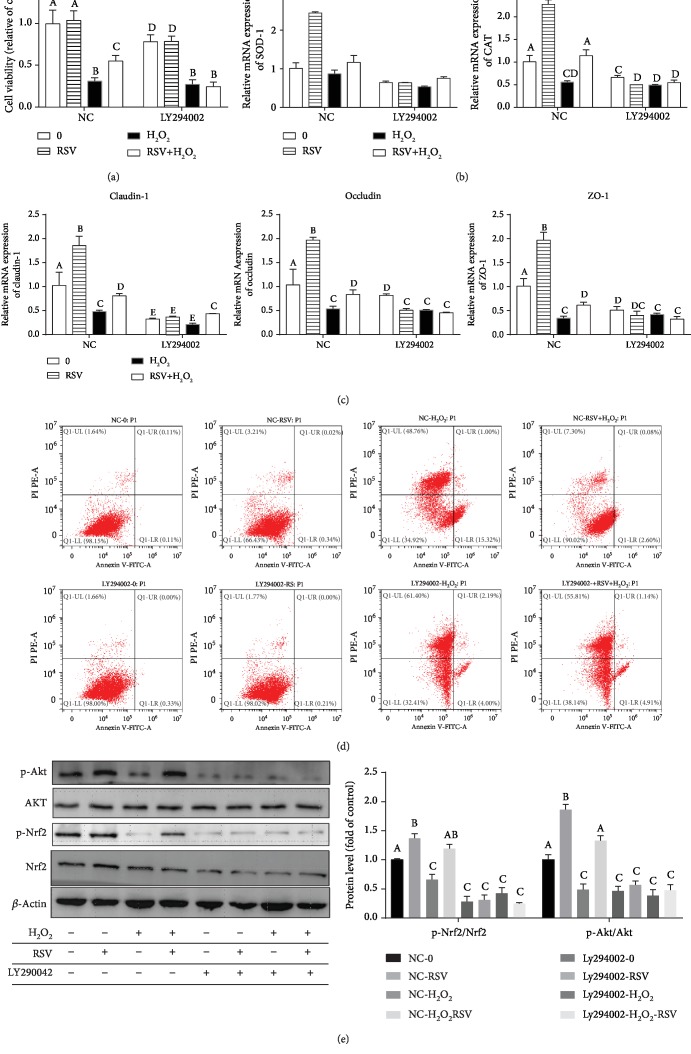
Effects of RSV and the selective inhibitor LY294002 on H2O2-induced cytotoxicity in IPEC-J2 cells. IPEC-J2 cells were pretreated with 25 μM LY294002 for 2 h and then treated with 50 μM RSV for 4 h before incubation with 500 μM H2O2 for 4 hours. (a) Cell viability was measured using the CCK-8 assay. Results are presented as the percentage of cell viability compared with the control (0 μM). (b, c) The relative expression of SOD-1, CAT, claudin-1, occludin, and ZO-1 was detected by qRT-PCR. Data are shown as ratios of abundance of target gene transcripts in the treated cells to those in the control cells after normalization to β-actin. (d) The apoptotic cells were analyzed by flow cytometry using Annexin V-PI double staining. (e) Protein levels of Nrf2, Akt, p-Nrf2, and p-Akt were detected by Western blot with β-actin as the loading control. Values are the mean ± SE. The columns with the same superscript capital letters and with different superscript capital letters mean no significant difference (P > 0.05) and significant difference (P < 0.05), respectively.